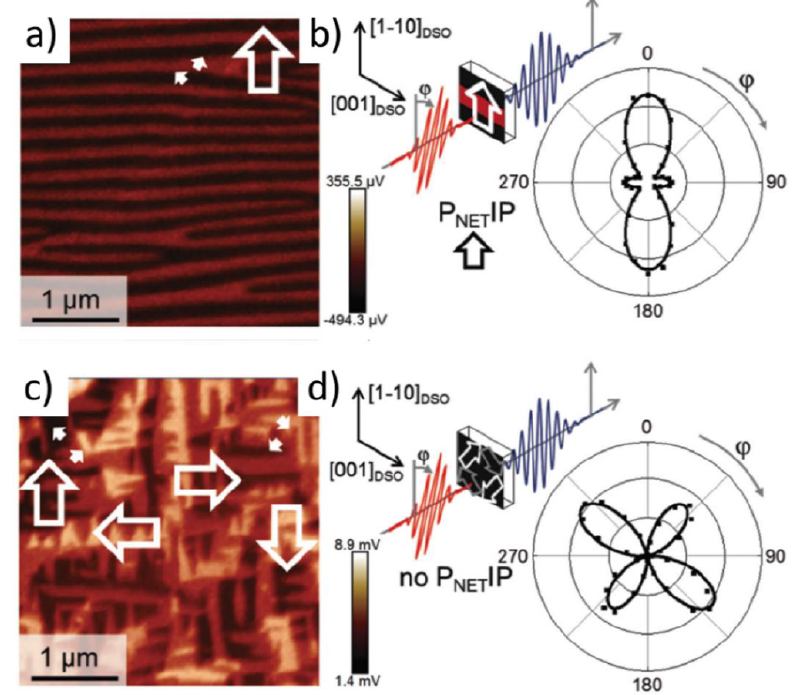
Figure 9. SHG on domain-engineered multiferroic BFO. ( a ) PFM scan of a stripe-like domain BFO film. ( b ) Polarizer measurement evidencing a net in-plane polarization in the film. ( c , d ) Corresponding PFM and polarizer measurement for an isotropic domain distribution, respectively. The signal observation in ( d ) does not depend on the sample crystalline orientation. Reproduced with permission from [88], Copyright Wiley-VCH Verlag GmbH and Co. KGaA,